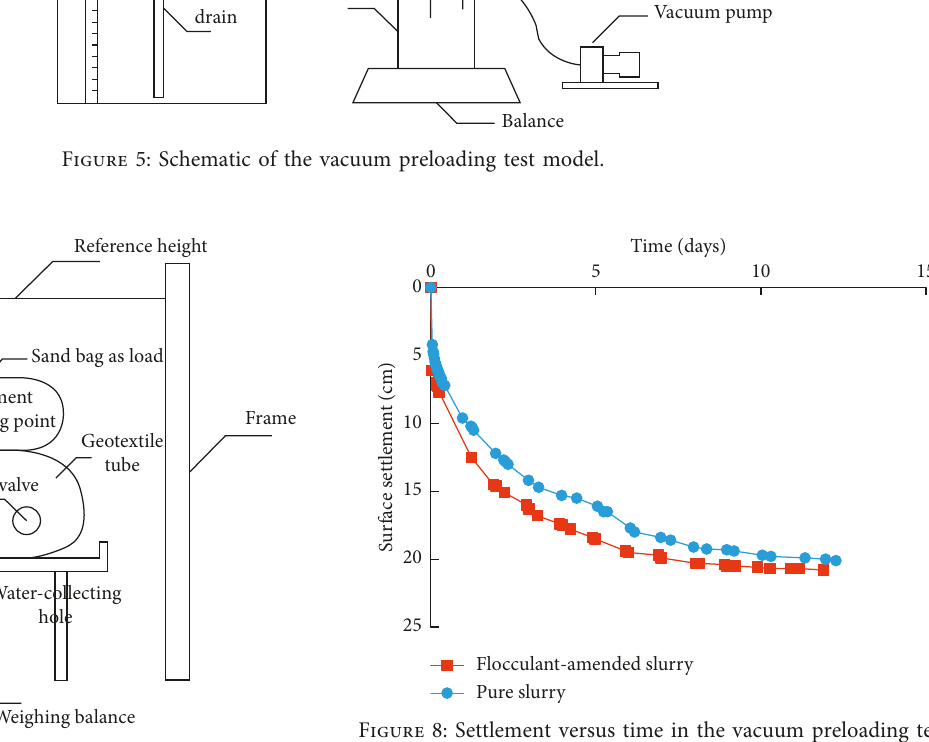
Figure 6: Schematic of the geotextile tube test model.